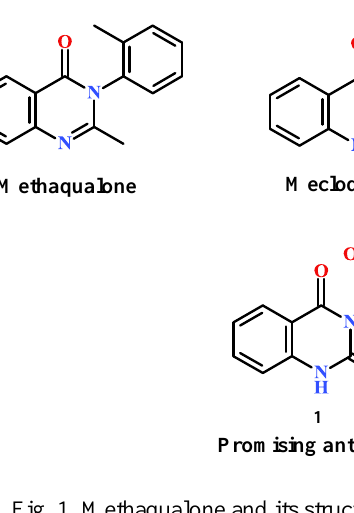
Fig. 1. Methaqualone and its structural analogues with anticonvulsant activity N-[(2,4-dichlorophenyl)methyl]-2-(1-(R-benzyl)- 2,4-dioxo-quinazolin-3-yl)acetamides was synthesized